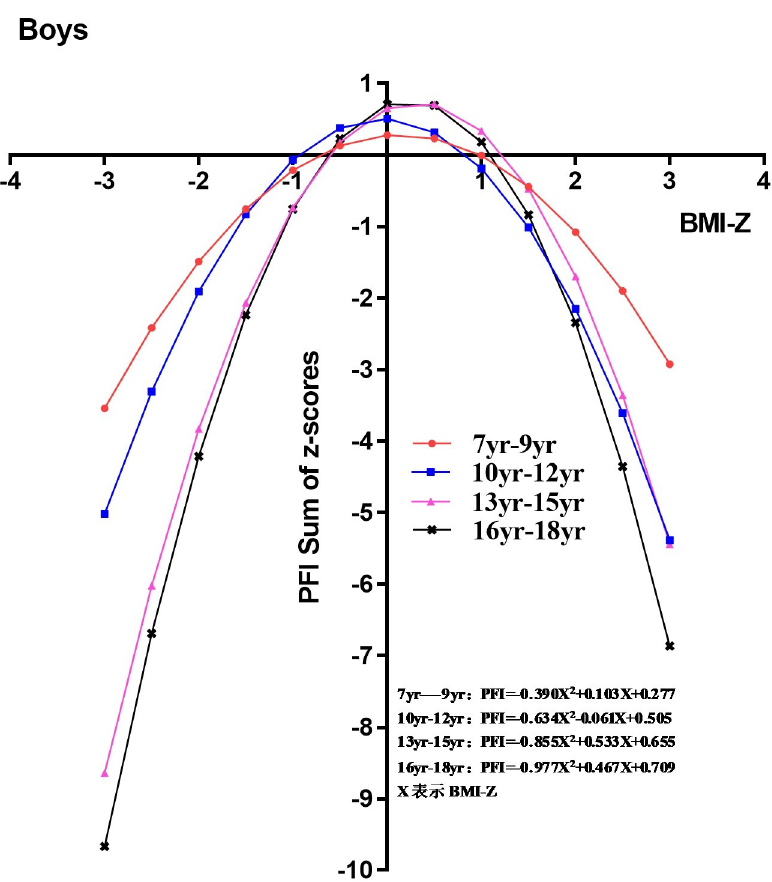
Fig 2. Linear regression analysis of physical fitness index and body mass index for boys in different age groups.